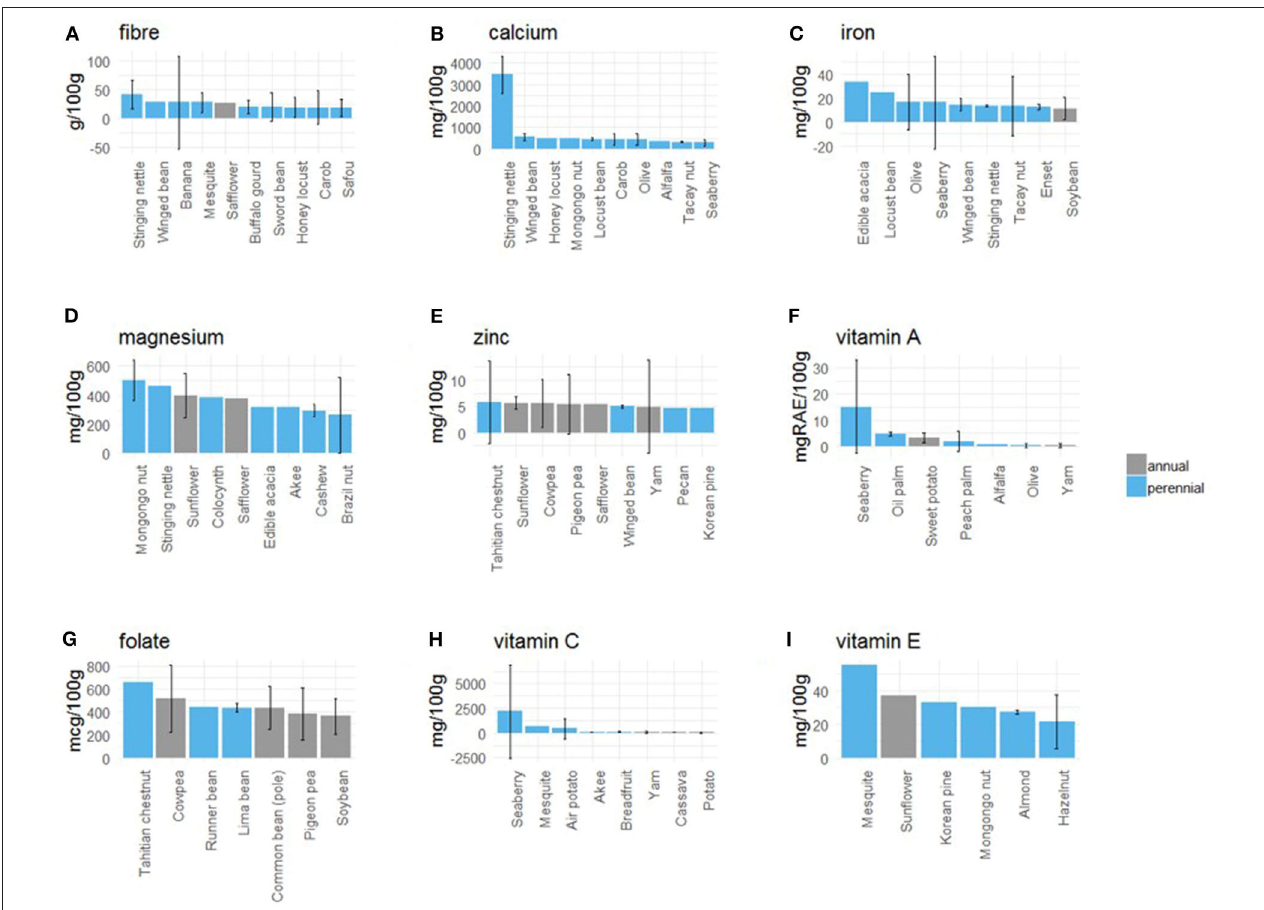
FIGURE 5 | Micronutrient content of perennials. Plots (A–I) show the crops in the 85th percentile and higher for micronutrient content (g/100g). Error bars are 95% CIs; if absent, only one source of nutritional data was available for that nutrient of that crop. Nutrient content is based on the dry, edible portion of each crop. Note that pigeon pea can be grown as an annual or perennial, but there isn’t separate nutritional information for each. Error bars reflect wide nutrient composition variation reported in the literature, and may reflect different crop varieties, soils, and growing systems. For example, there are hundreds of varieties of bananas, seaberry ( Elaeagnus rhamnoides) is a new crop with a wide genetic base, and Tahitian chestnut ( Inocarpus fagifer ) is grown on hundreds of Pacific islands, with populations that have been isolated by thousands of miles for millennia.